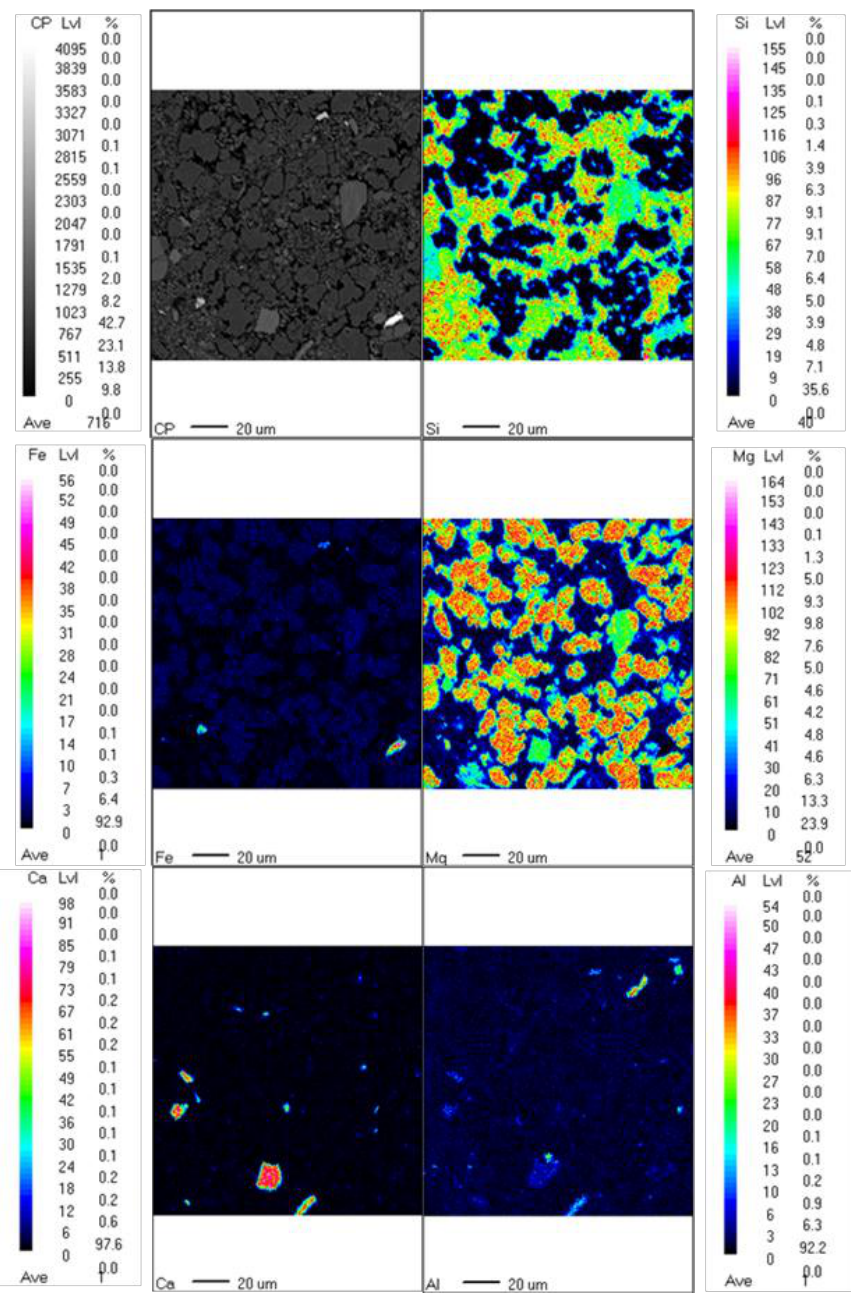
Figure 7. Backscattered scanning electron image and elemental concentration mapping (silicon, iron, magnesium, calcium and aluminum) of fully carbonated olivine, captured by EPMA; color scale indicates max/min